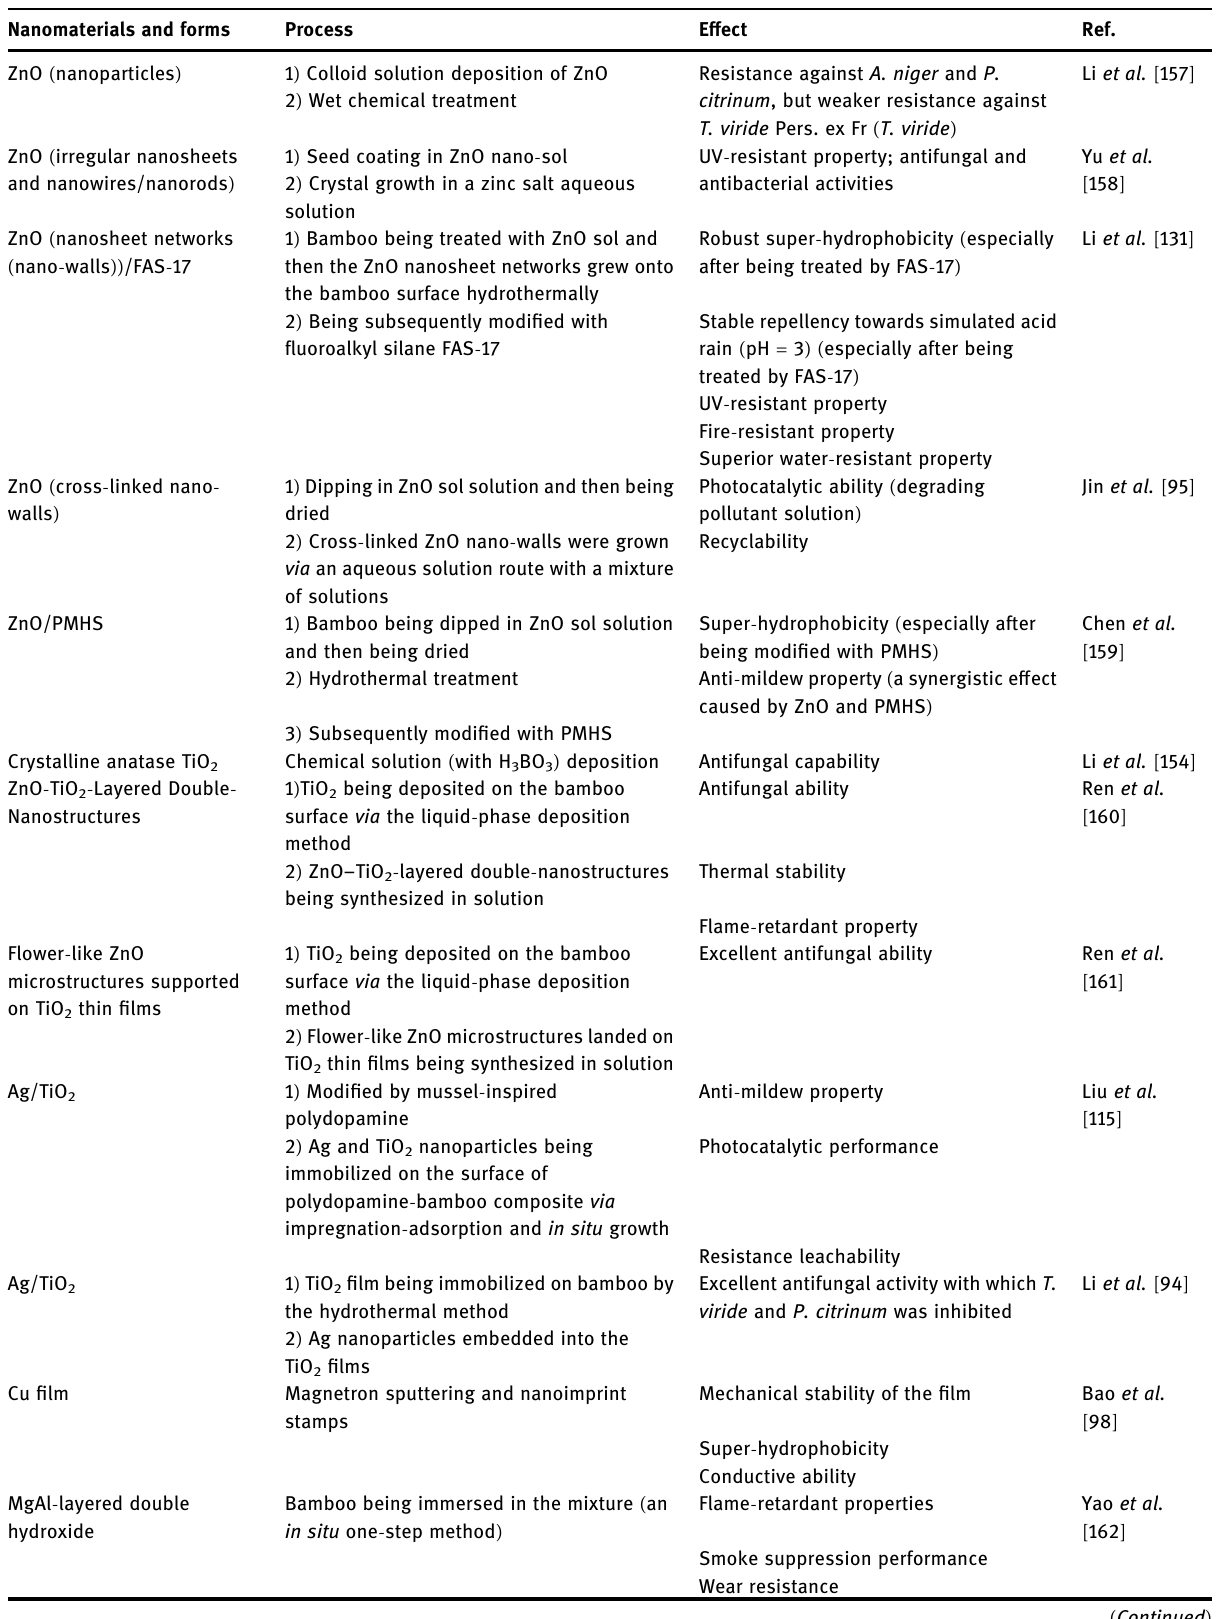
Table 4: Some coating processes and e ff ects of nanomaterials Nanomaterials and